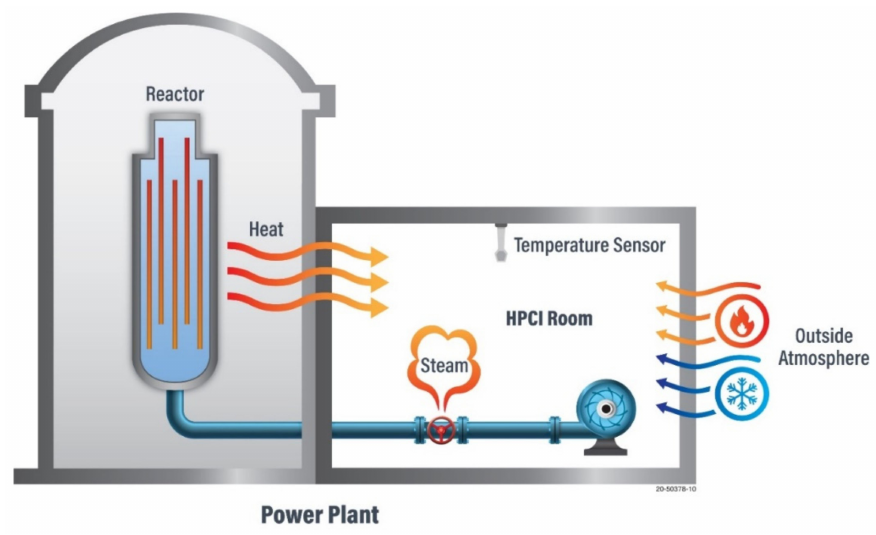
Figure 3. Initial strategy applied to HPCI anomaly detection.